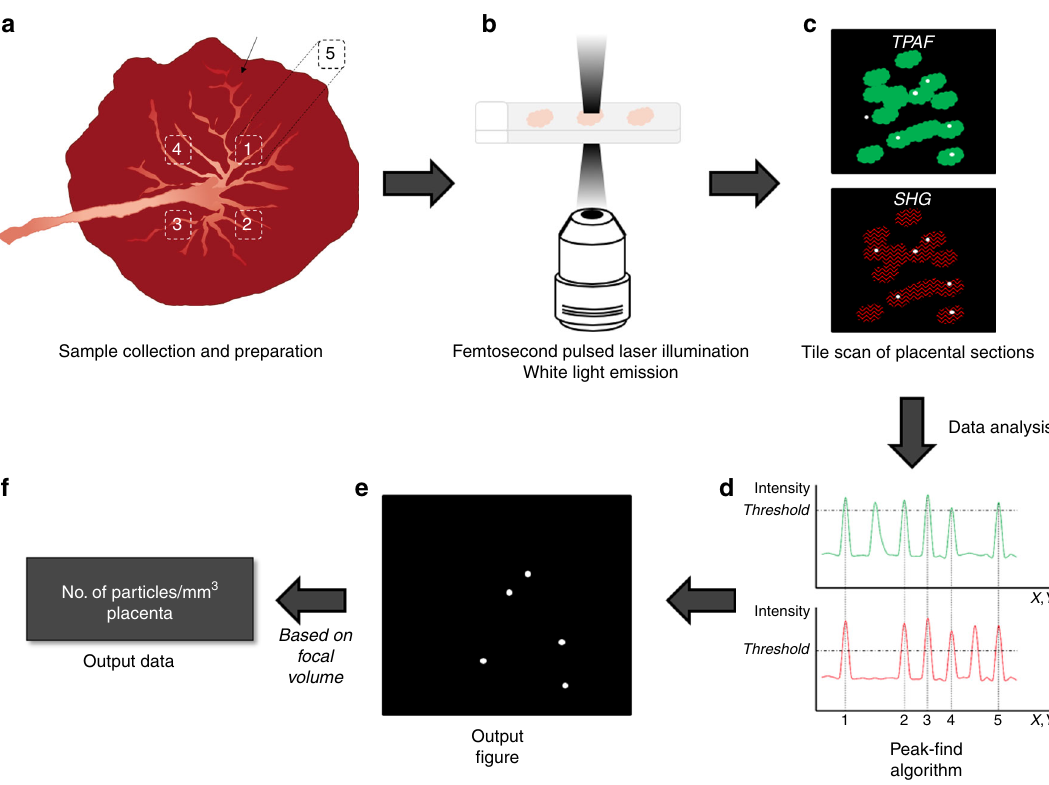
Fig. 1 Flowchart of the experimental protocol for BC detection in the placenta. a Five biopsies are taken in total, of which four on the fetal side of the placenta at distinct positions oriented according to the main blood vessel (black arrow), and one (biopsy 5) at the maternal side of biopsy 1. After sample collection, the biopsies are embedded in paraf fi n and sections of 4 µ m are prepared. b The placental sections are illuminated using a two-photon femtosecond pulsed laser tuned to a central wavelength of 810 nm (10 mW radiant power at the sample). c The WL produced by the BC naturally present in the tissue (white dots) is detected along with the simultaneous generation and detection of two-photon excited auto fl uorescence (TPAF) of the cells (green) and second harmonic generation (SHG) from collagen (red) (see materials and methods for detailed protocol). A tile scan of 10 × 10 images